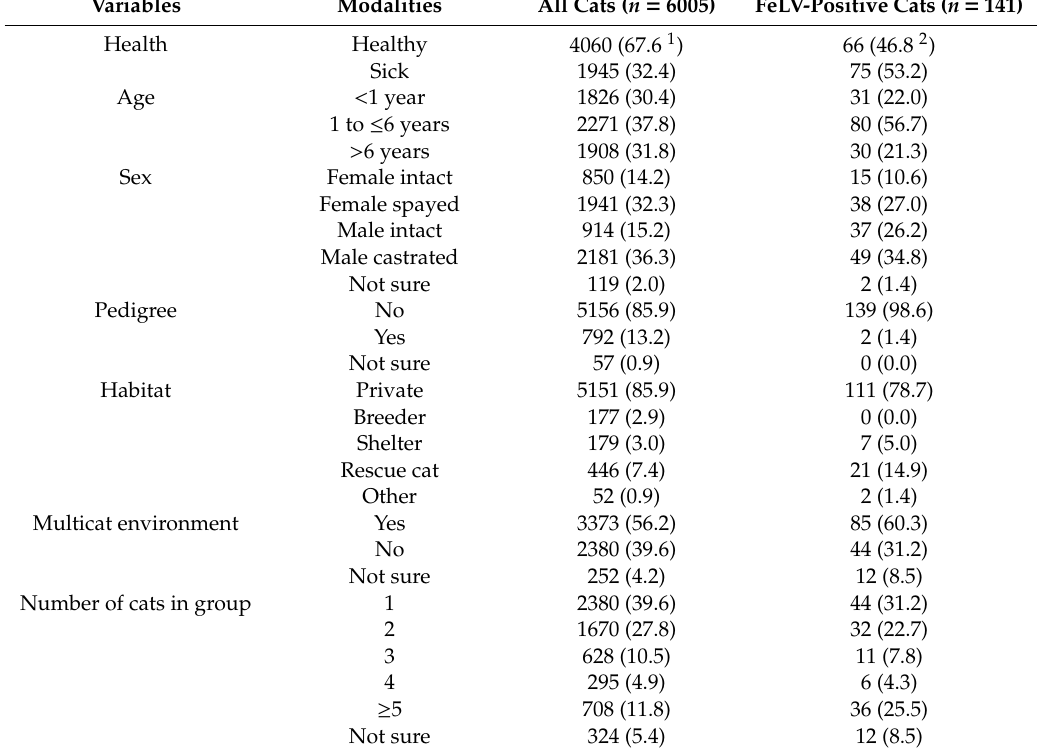
Table 2. Sample characteristics (all cats and FeLV-viraemic